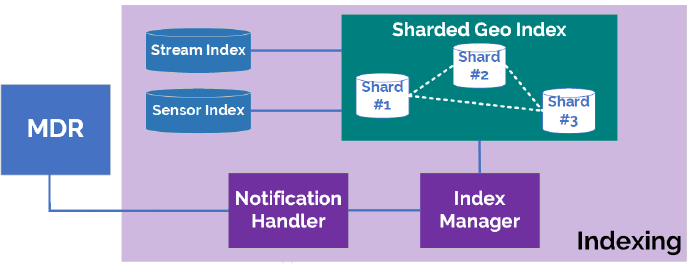
Figure 10. Indexing sensors and